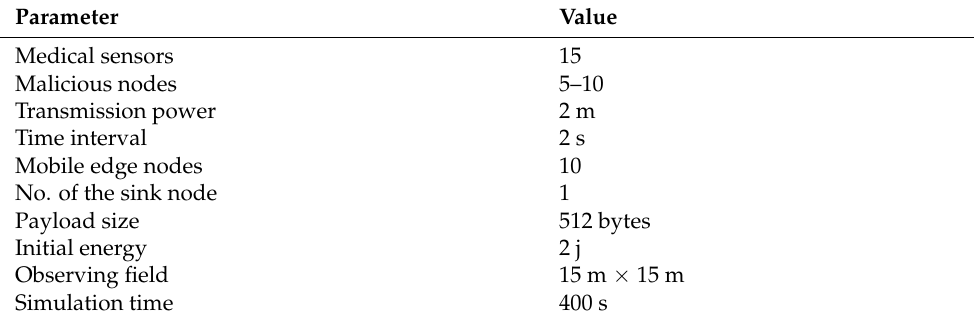
Table 1. Simulation